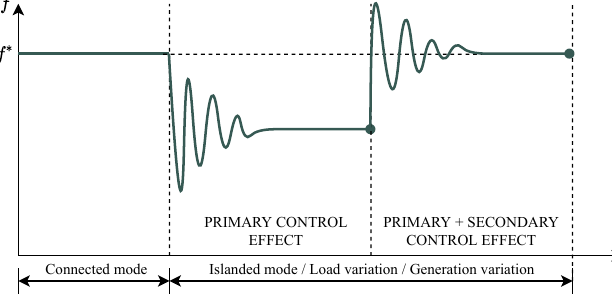
Figure 2. Primary and secondary control effect on islanded microgrids after a